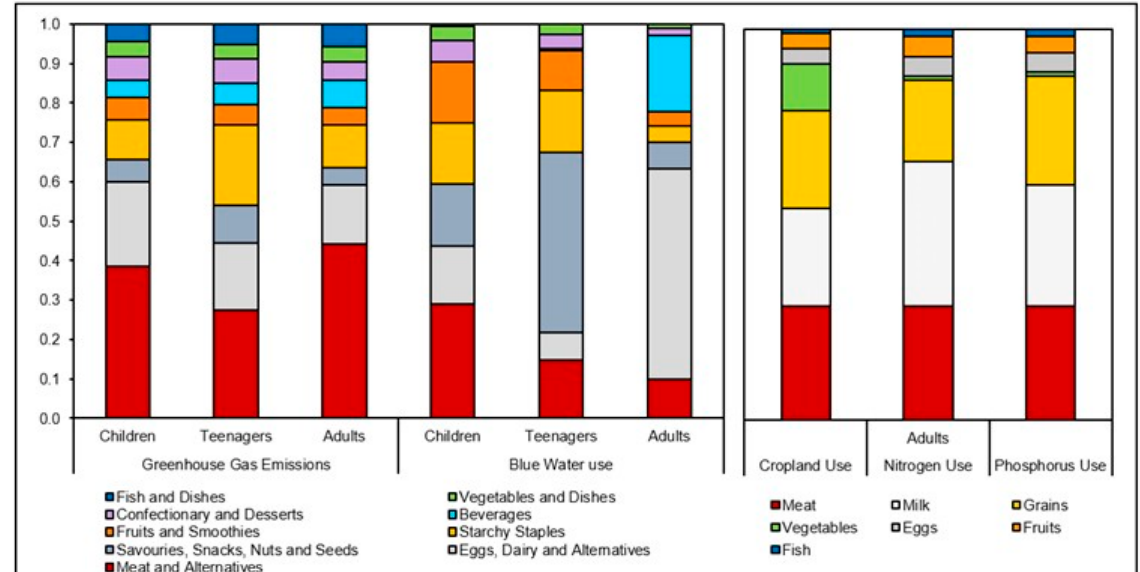
Figure 2. Percentage contribution of food categories to environmental impact for greenhouse gas emissions and blue water use (as food consumed) and for cropland, nitrogen and phosphorus use (as agricultural commodities). Values shown are median percentages across all three population groups for GHGe and blue water use, and for adults for the remaining factors. Includes diets reported for children ( n = 2375); teenagers ( n = 798); adults ( n = 4575). Diets reported in the three surveys were weighted equally. Of the ‘eggs, dairy and alternatives’ group, dairy alternatives constitute 0.2%, 0%, and 0.2% for GHGe, and 6%, 0%, and 0.05% for children, teenagers, and adults for water use, respectively. Meat alternatives constitute 4%, 1%, and 3% for GHGe and 5%, 1%, and 1% for water use for children, teenagers, and adults, respectively. Starchy staples include breads and rolls; breakfast cereals; potatoes and products; and rice, pasta, flours, and starches.